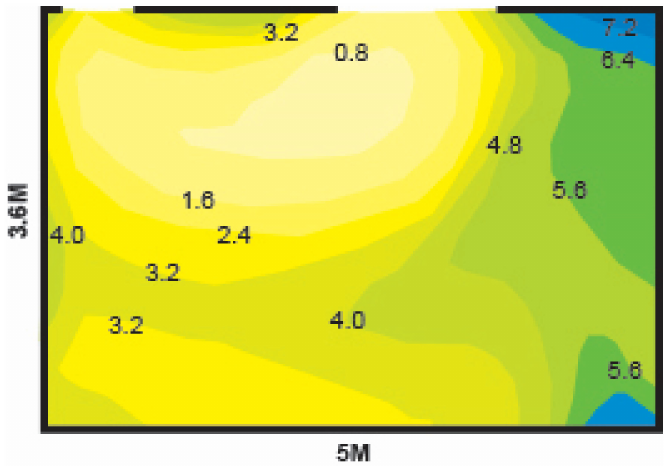
Figure 6. ACH = 3 times, average concentration: 3.48 pci (Max: 7.84 pci, Min: 0.54 pci).